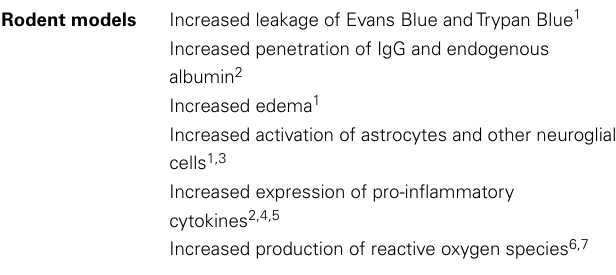
Table 2 | Summary of the preclinical and clinical literature on MDMA-induced BBB